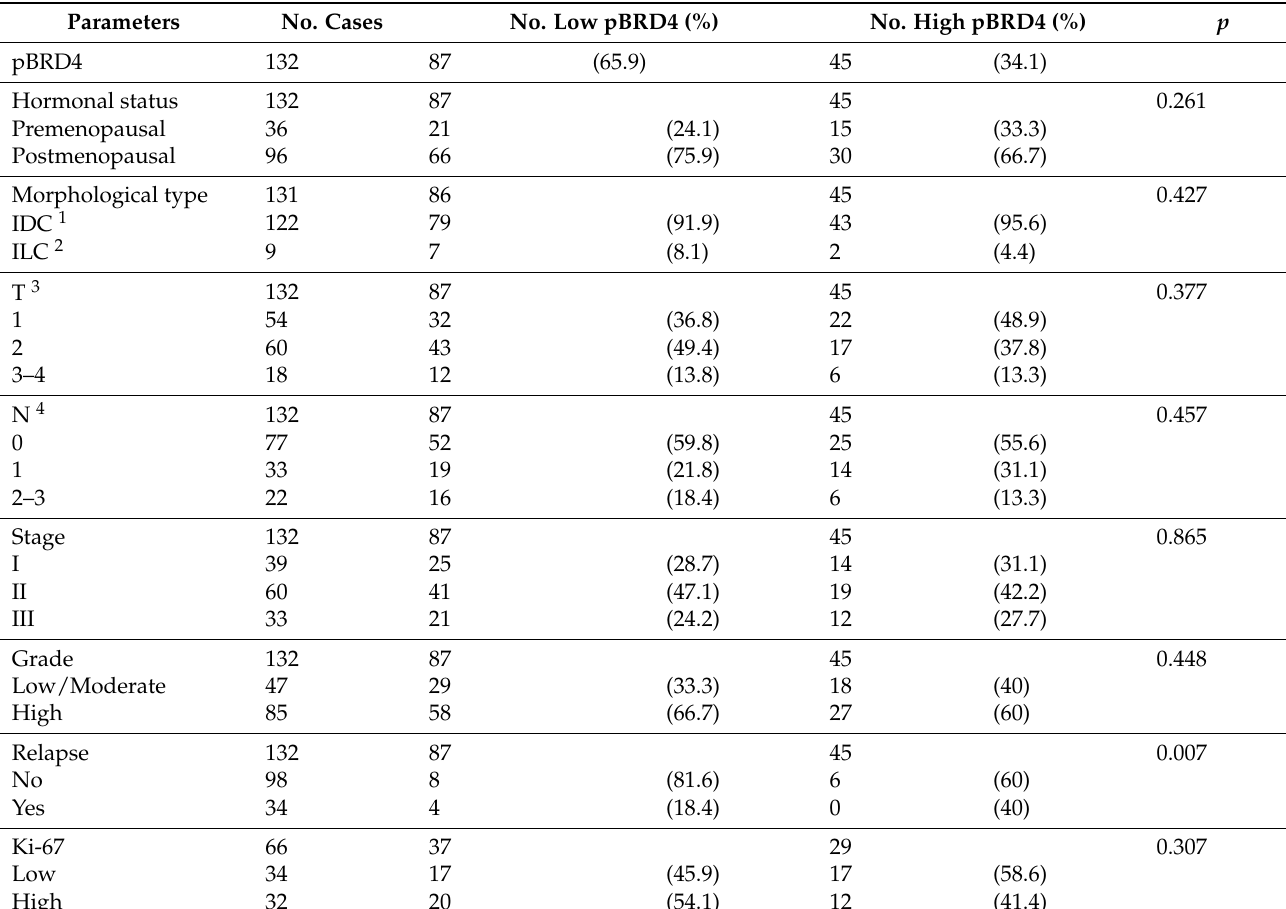
Table 1. Association of bromodomain-containing protein 4 (BRD4) phosphorylation levels with molecular and clinical parameters in a cohort of 132 triple negative breast cancer (TNBC) patients.